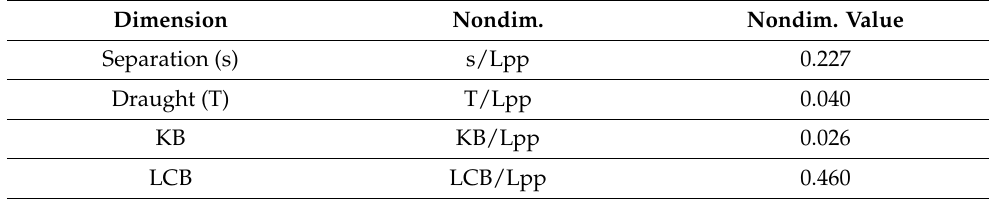
Table 1. Principal dimensions of the Stavanger Demonstrator. Dimension Nondim.